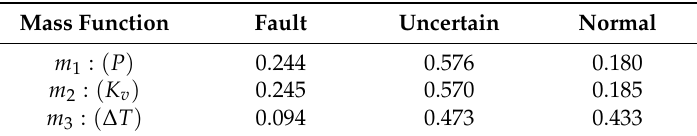
Table 3. The weighted mass functions.